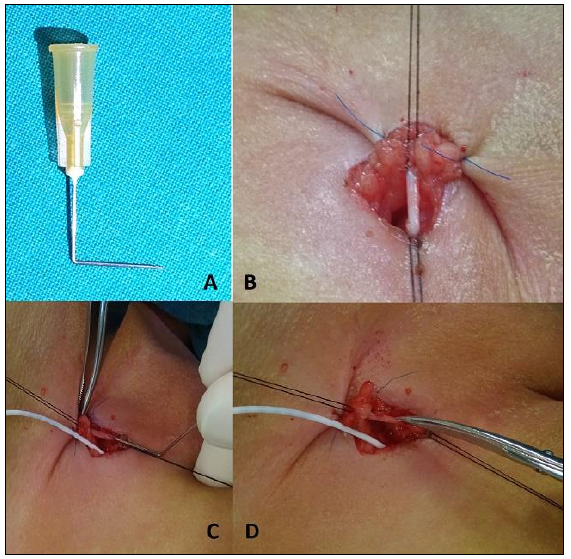
Figure 1: Steps of venous cut down. A 22-24G insulin needle is bent at right angle by a clamp for about 1 cm (Fig.1A). Once the saphenous vein is exposed, encircled and loaded over threads, two stay suture including the subcutaneous tissue, the superior edge of skin incision and the skin over the inguinal crease are placed in order to expose the operative field and to leave the assistant with